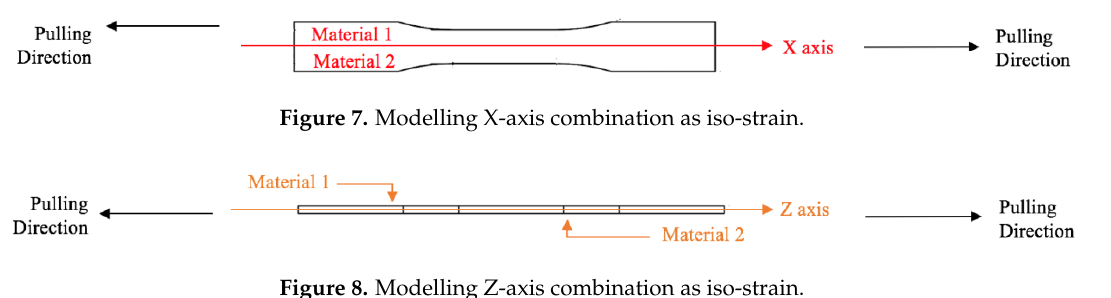
Figure 8. Modelling Z-axis combination as iso-strain.